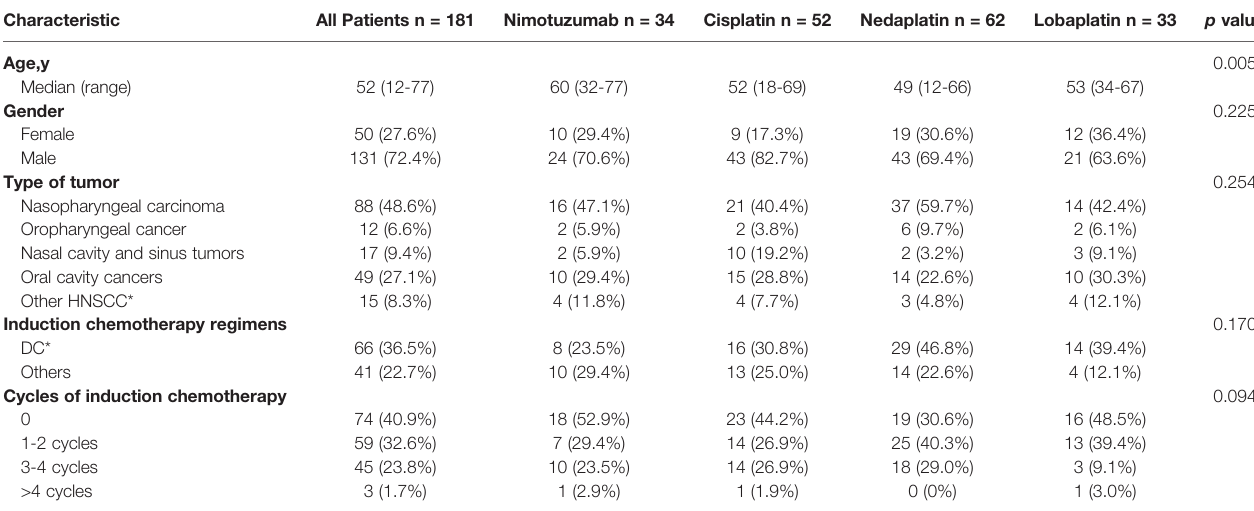
TABLE 1 | Characteristics of LAHNC patients.